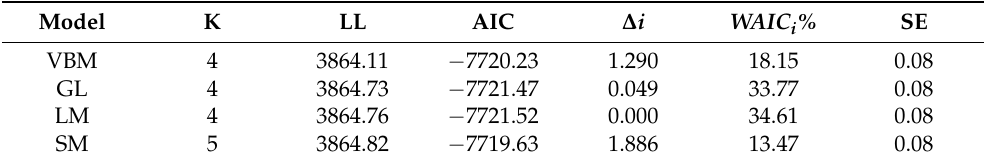
Table 5. Growth model selection for models fitted to raw age-length data of the temperate Sardinops sagax stock in the southern California Current System (CCS). K is the number of parameters; LL is the maximum log-likelihood; AIC is the Akaike’s information criterion; ∆ i is Akaike’s differences; WAIC i % is Akaike’s weight for each model; SE is the standard error.